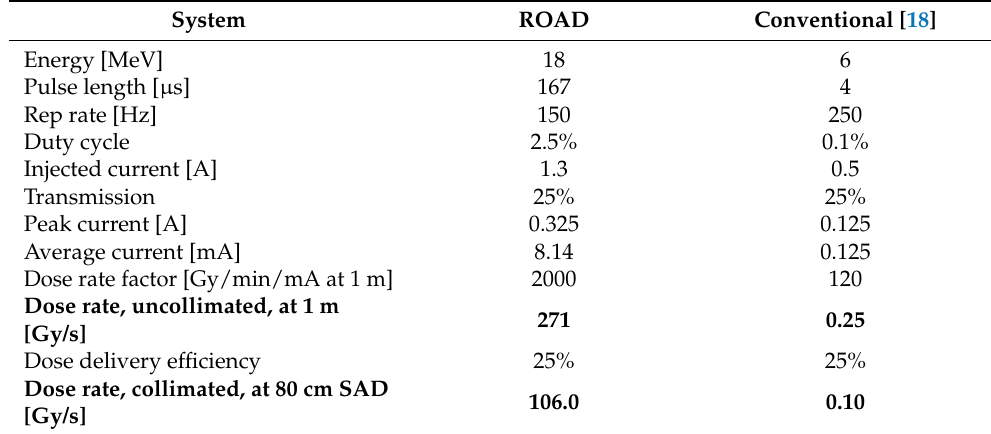
Table 4. Parameters of ROAD high-current electron linear accelerator for X-ray FLASH therapy.